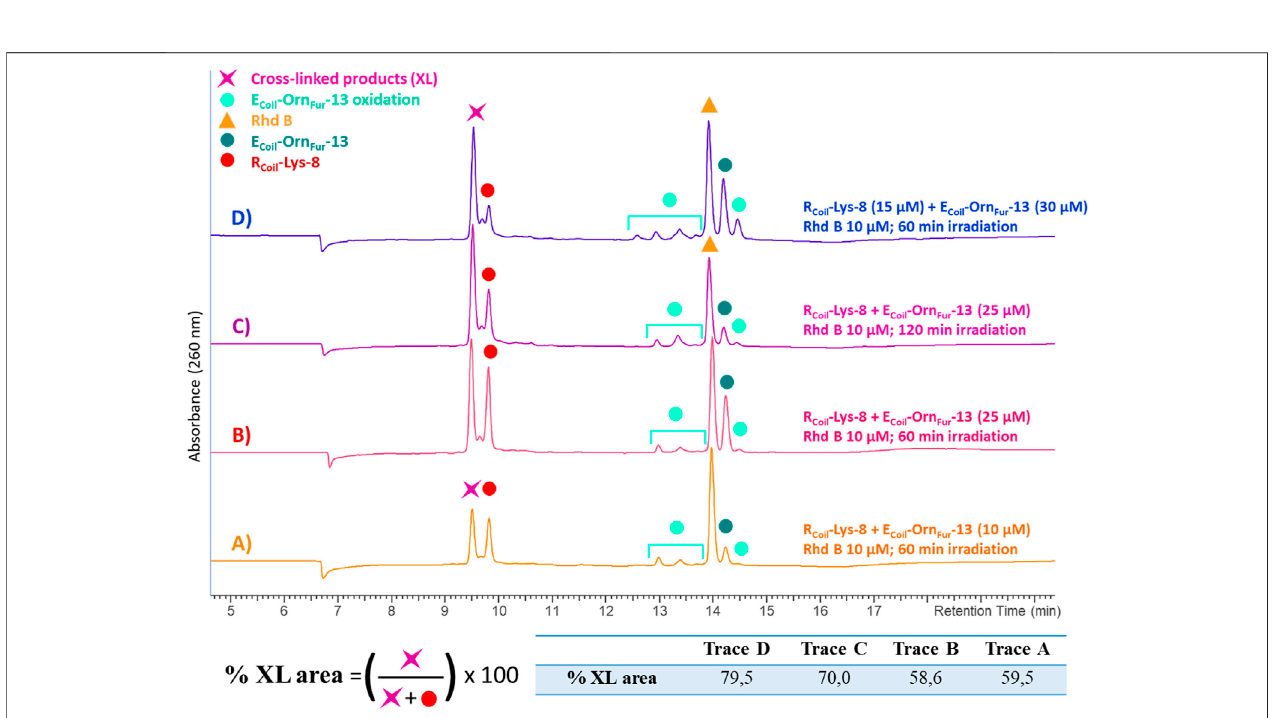
FIGURE 6 | All the chromatograms show the cross-link reaction product (purple star) between R Coil -Lys-8 (red dot) and E Coil -Orn Fur -13 (dark green dot) after light irradiation with Rhd B (orange triangle) at 10 μ M. The E Coil -Orn Fur -13 oxidation products (light green dots) are produced after activation of the furan moiety by singlet oxygen generation. (A) R Coil -Lys-8 (10 μ M) and E Coil -Orn Fur -13 (10 μ M) and 60 min of light irradiation. (B) R Coil -Lys-8 (25 μ M) and E Coil -Orn Fur -13 (25 μ M) and 60 min of lightirradiation. (C)